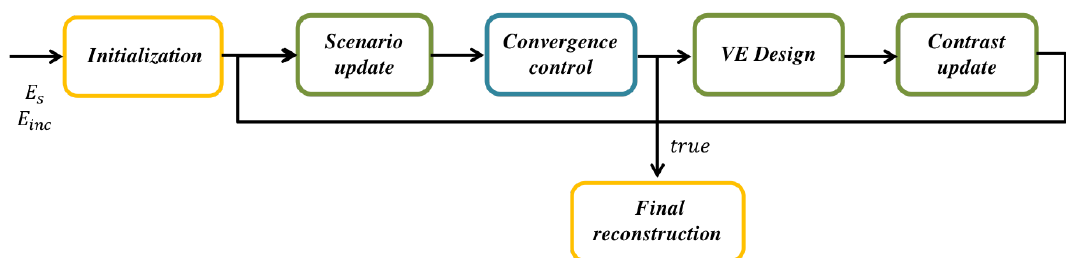
Figure 1. Sketch of distorted iterated virtual experiments (DIVE) scheme.